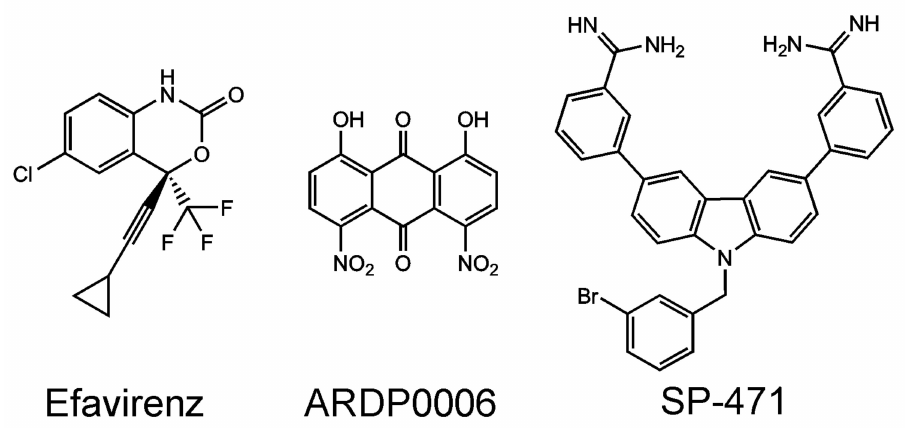
Figure 5. Compounds binding precursors of viral proteases: efavirenz binds to the Gag-Pol precursor, leading to the premature activation of the HIV protease, whereas ARDP0006 and the carbazole derivative SP-471 block intrahelicase cis-cleavage in Dengue